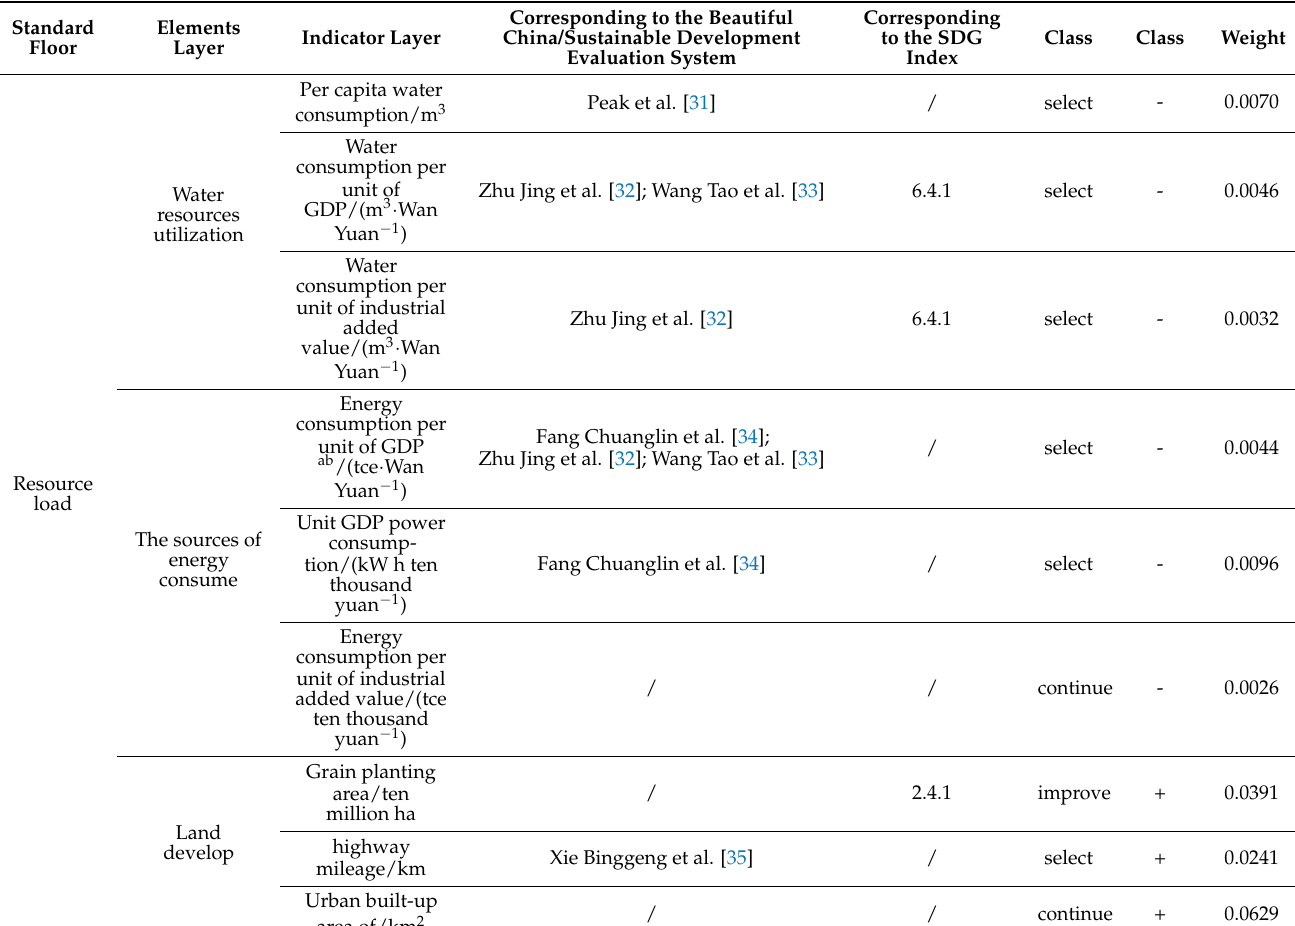
Table 1. Evaluation index system for high-quality development in YGR based on Beautiful China and